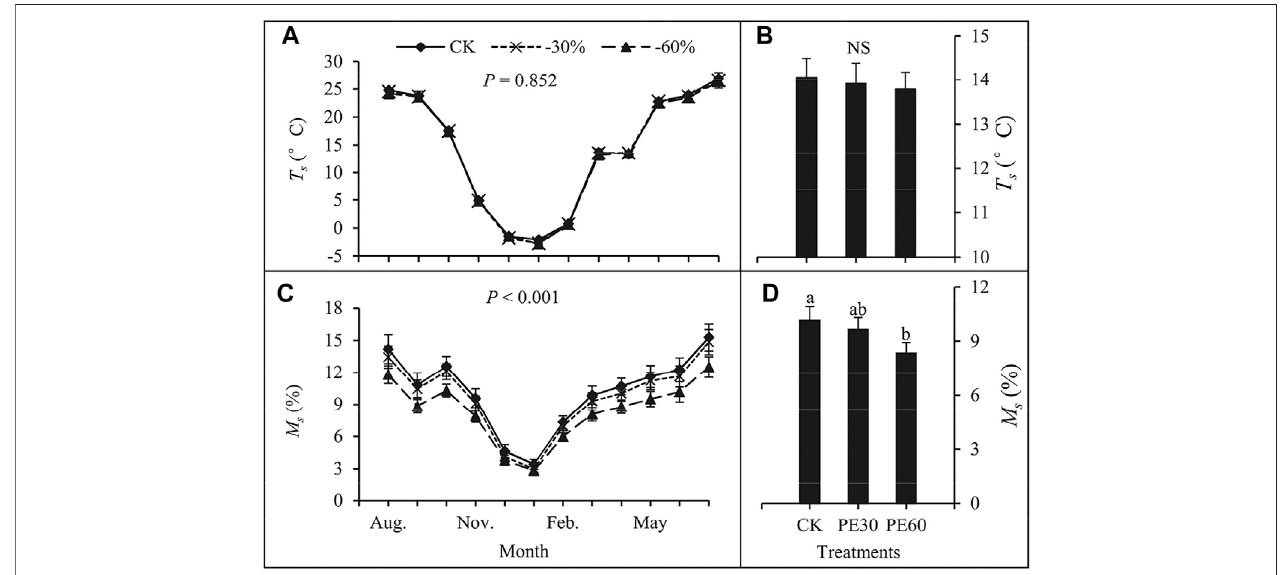
FIGURE 2 | Seasonal variation in (A) soil temperature ( T s ) at 10 cm depth, and (C) soil moisture ( M s ) at 10 cm depth from August 2016 to July 2017. Data are the mean ± SD( n (cid:2) 3). Monthlymeanvaluesof (B) T s and (D) M s throughout thestudyperiod.Lettersonthetopofthebarsindicatesigni fi cantdifferenceamongtreatments at level of p < 0.05. CK: ambient precipitation; PE30: 30% reduced precipitation; PE60: 60% reduced